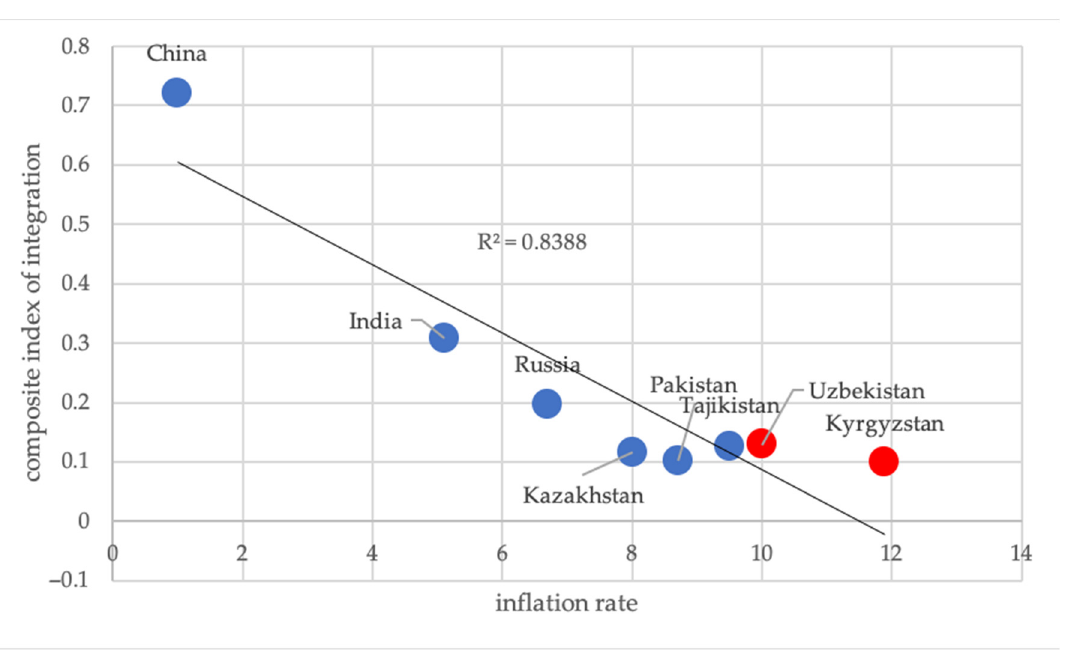
Table 6. Results of correlation analysis of inflation and trade integration factors.